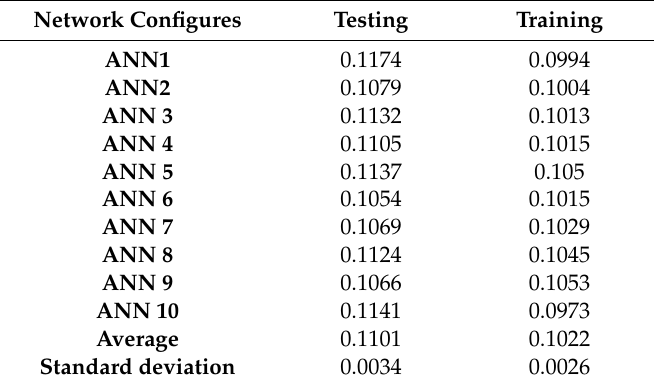
Figure 3. The anticipated ANN architect for 10 neurons. Note: CC adoption (CCA); Compatibility (CT); Competitive pressure (CP); Complexity (CX); Cost saving (CS); Technology readiness (TR); Top manager’s support (TMS); Security (SC). Table 8. RMSE values of artificial neural